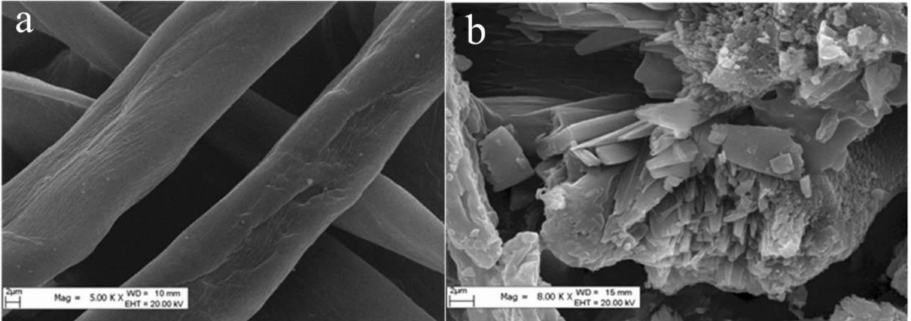
Figure 2. SEM images of ( a ) cotton linters cellulose and ( b ) S-CSHE.